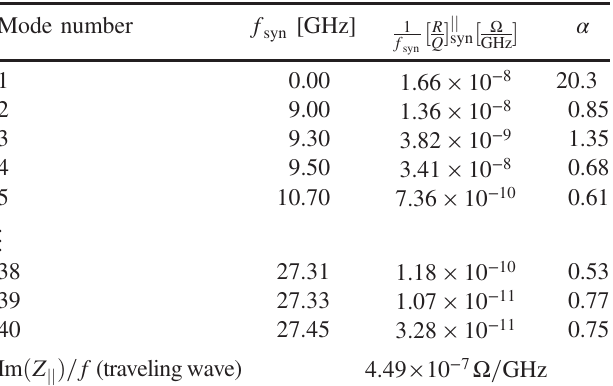
TABLE VI. Longitudinal traveling wave data for one period of the FCC-hh beam screen depicted in Fig. 1. The final result for Im ð Z jj Þ =f is the sum of the elements of the third column weighted with the corresponding factors α .